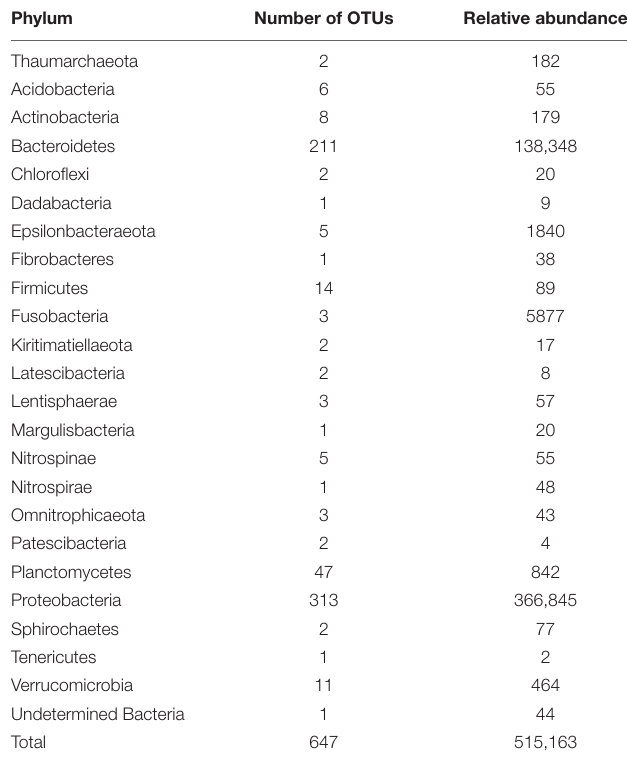
TABLE 1 | OTU and sequence frequencies by phylum from samples of Isodictya kerguelenensis maintained under experimental conditions.